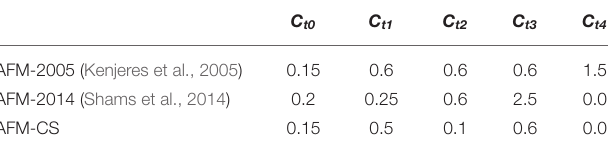
TABLE 1 | Model coefficients for the algebraic turbulent heat flux model.